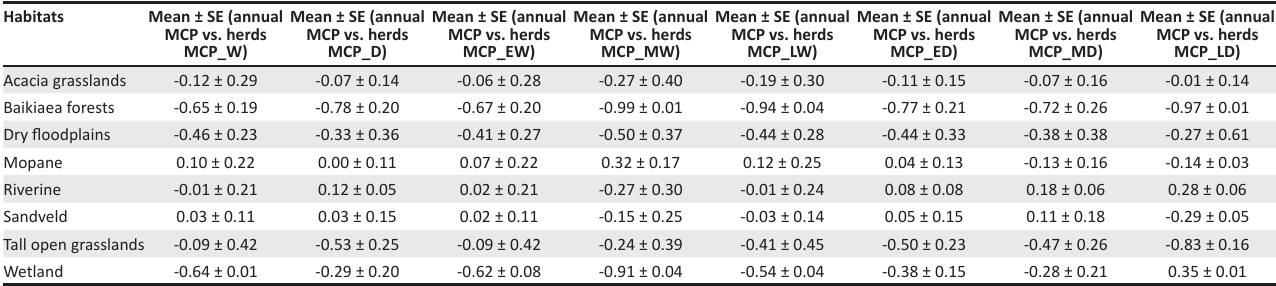
TABLE 2: Second-order habitat selection (annual minimum convex polygons vs. wet or dry seasons minimum convex polygons) by three buffalo in the Savuti–Mababe– Linyanti ecosystem (northern Botswana). Habitats Mean ± SE (annual Mean ± SE (annual Mean ± SE (annual Mean ± SE (annual Mean ± SE (annual Mean ± SE (annual Mean ± SE (annual Mean ± SE (annual MCP vs. herds MCP vs. herds MCP vs. herds MCP vs. herds MCP vs. herds MCP vs. herds MCP vs. herds MCP vs. herds MCP_W) MCP_D) MCP_EW) MCP_MW) MCP_LW) MCP_ED) MCP_MD)